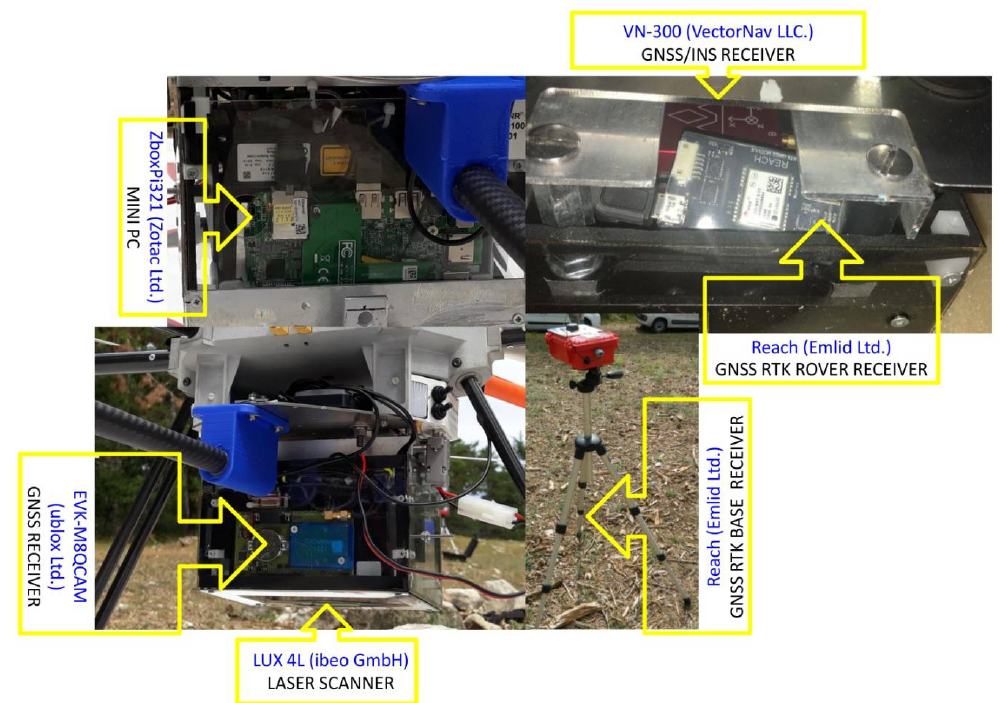
Figure 4. Details of the sensors integrated in the LasUAV and isolated by the case.